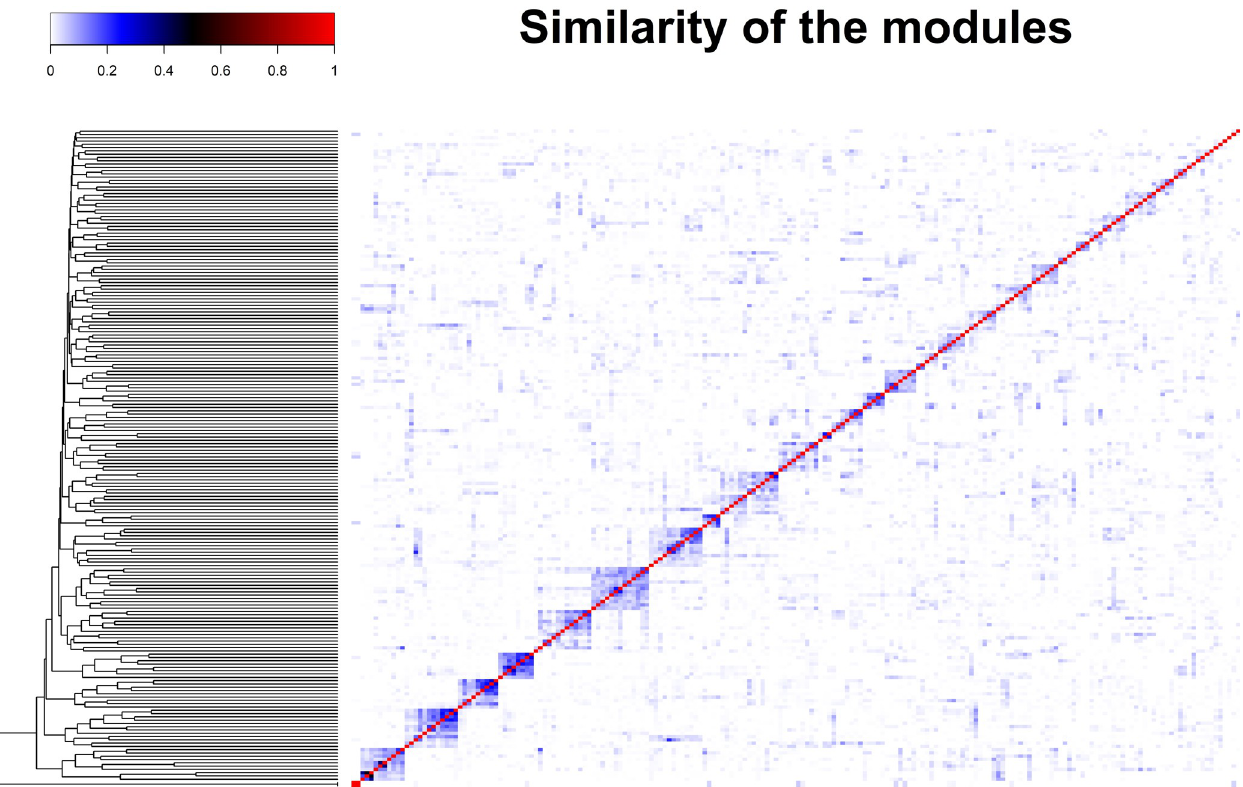
Fig 5. Heat map showing the similarity of the differential gene modules. Both x and y axis are individual modules.